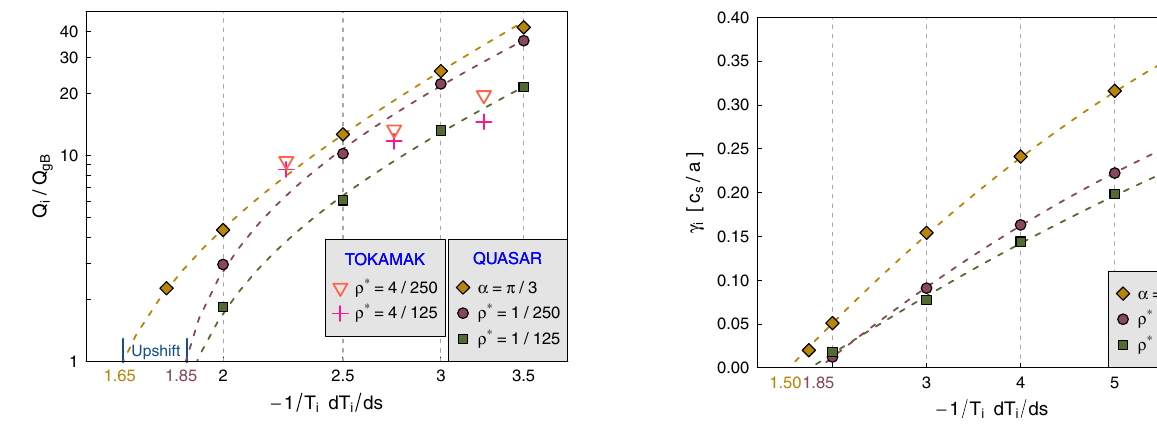
FIG. 7. Scaling of the linear growth rate for the ITG mode on the magnetic surface of the QUASAR stellarator (in the two ρ (cid:3) regimes) and the field line with α ¼ π = 3